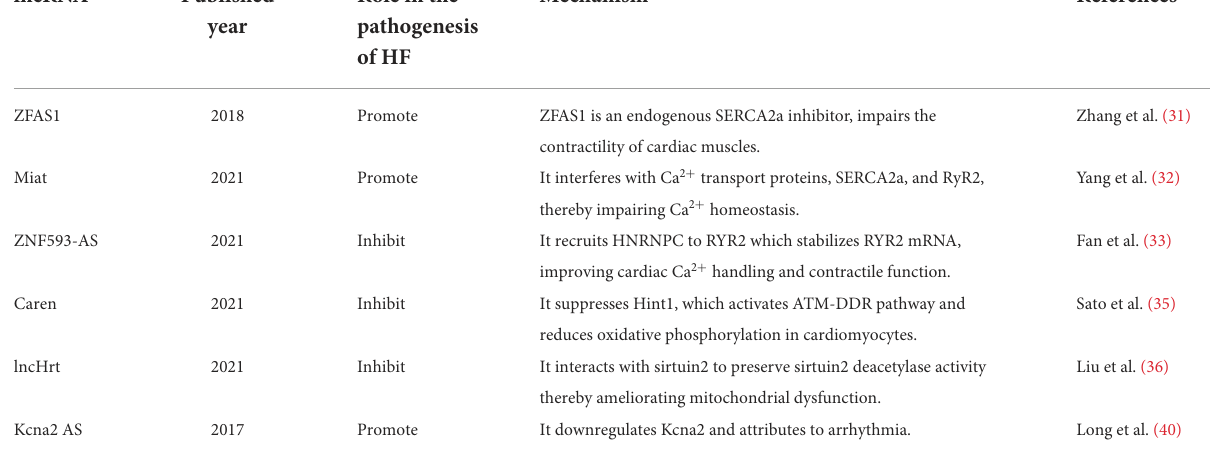
TABLE 1 lncRNAs modulating cardiomyocyte